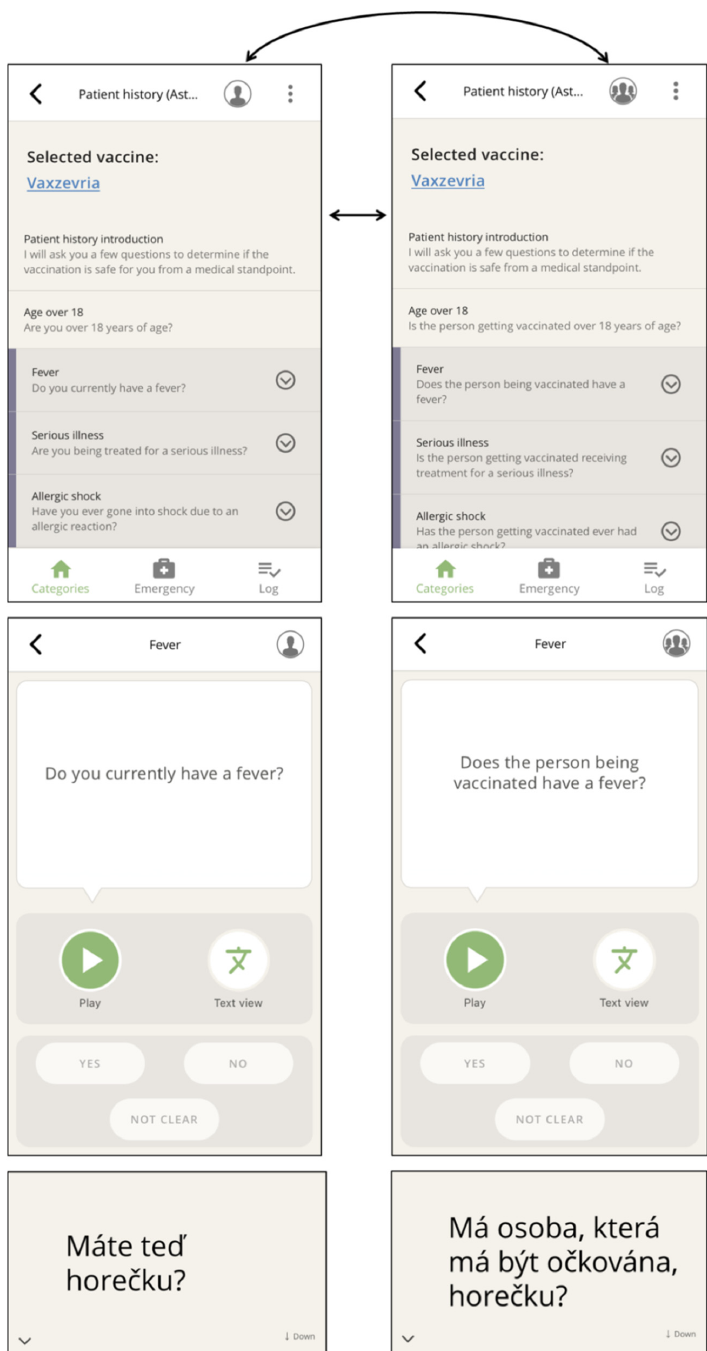
Figure 4. The addressed person can be toggled between by clicking on the portrait icon within categories ( top ) or directly on the selected question ( center ). The respective text display ( bottom ) can be reached via the text view button (smaller-scale screenshot rotated 90°) (here, Czech: “Do you currently have a fever?” and “Does the person being vaccinated have a fever?”).